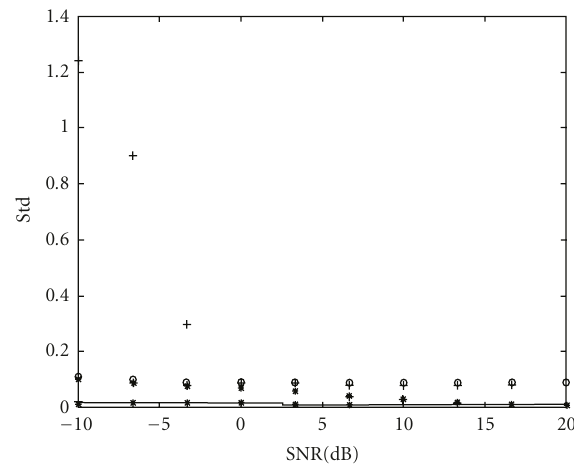
Figure 11: Pseudospectrum of MUSIC obtained using SVD.